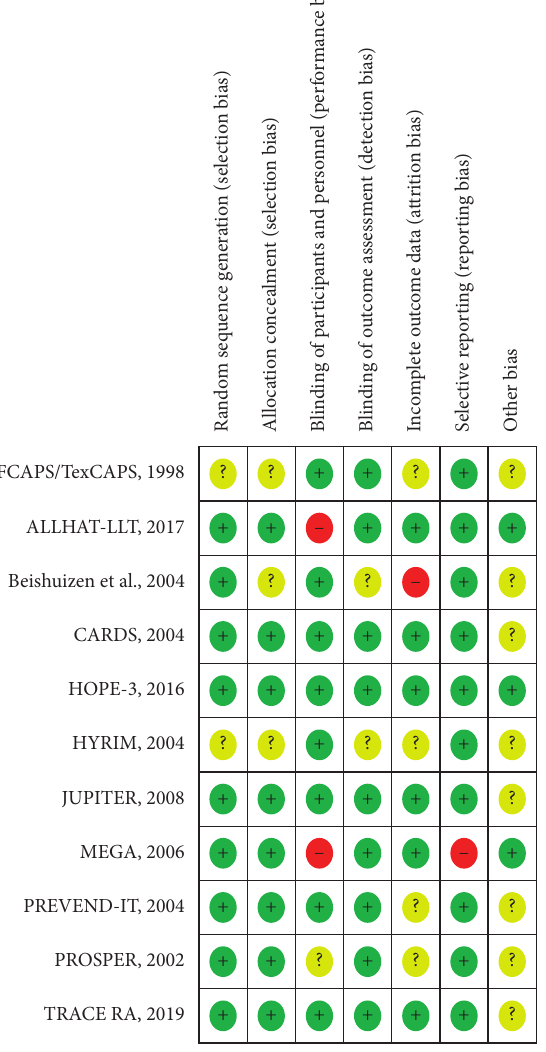
Figure 2: Risk of bias summary. Review authors’ judgments about each risk of bias item for each included